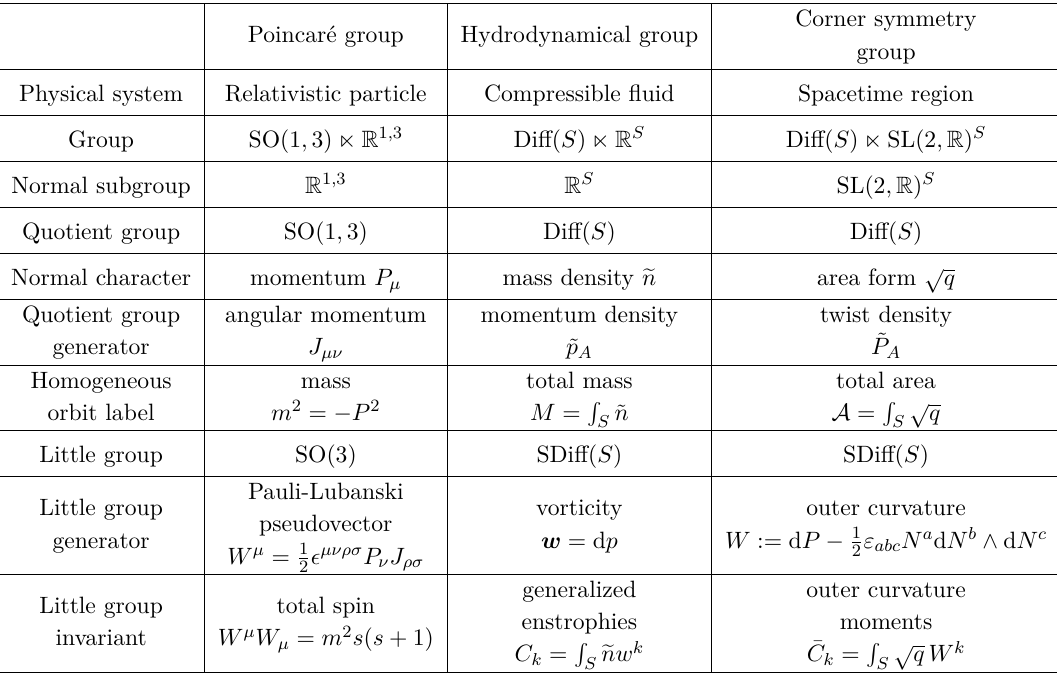
Table 1. The analogy between classification of coadjoint orbits for the Poincaré group (section 2.3), the symmetry group Diff ( S ) n R S of compressible hydrodynamics (section 3) and our corner